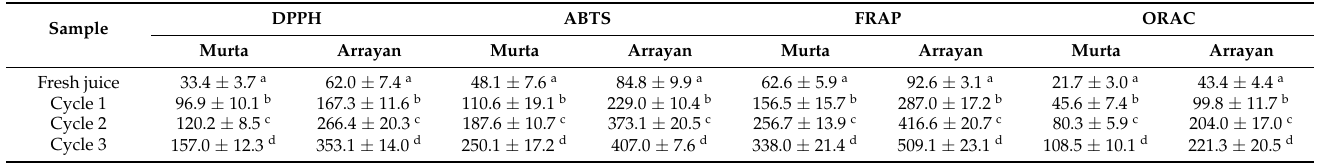
Table 3. Antioxidant activity ( µ M TE/g d.m.) of fresh juices and cryoconcentrated samples.